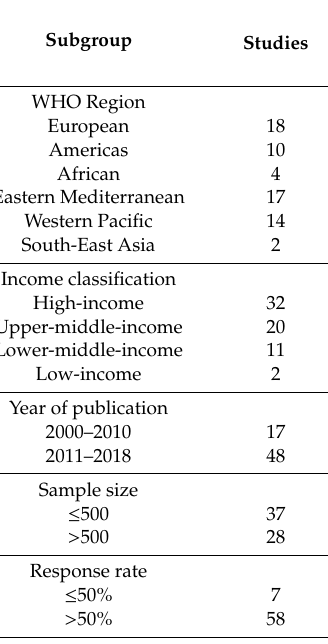
Table 2. Subgroup analysis of the pooled